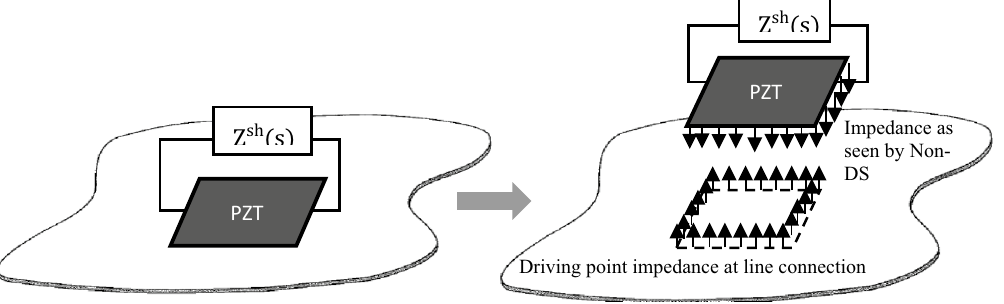
Figure 2. A PZT patch with a shunt circuit, Z sh ( s ) acting on a non-deterministic plate. The patch can be regarded as line moment exciter on the Non-DS, therefore the driving point impedance at line connection needs to be established 7